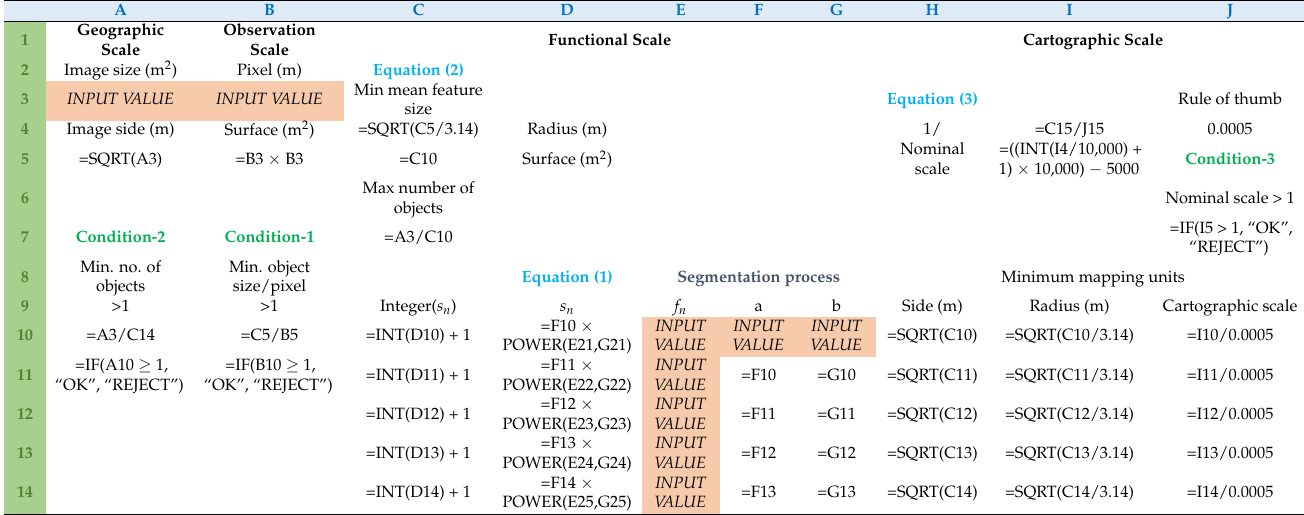
Table 1. The Excel spreadsheet of the scale calculator in function